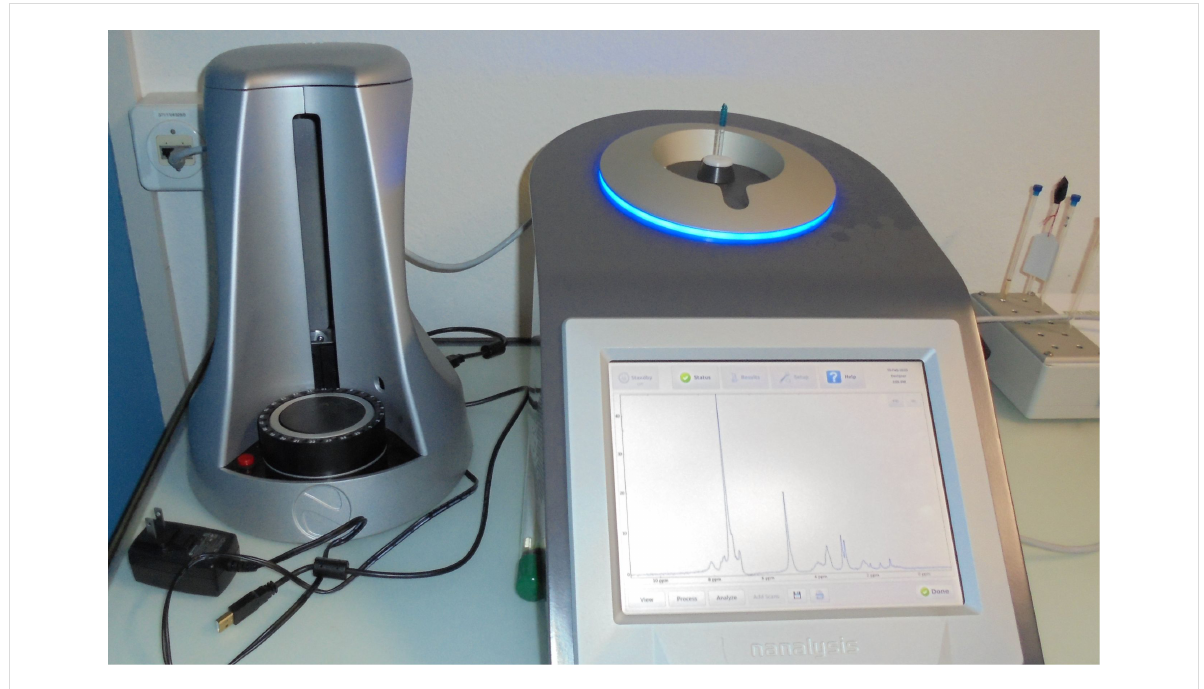
Figure 3: Pre-QC validation by 60 MHz benchtop NMR.